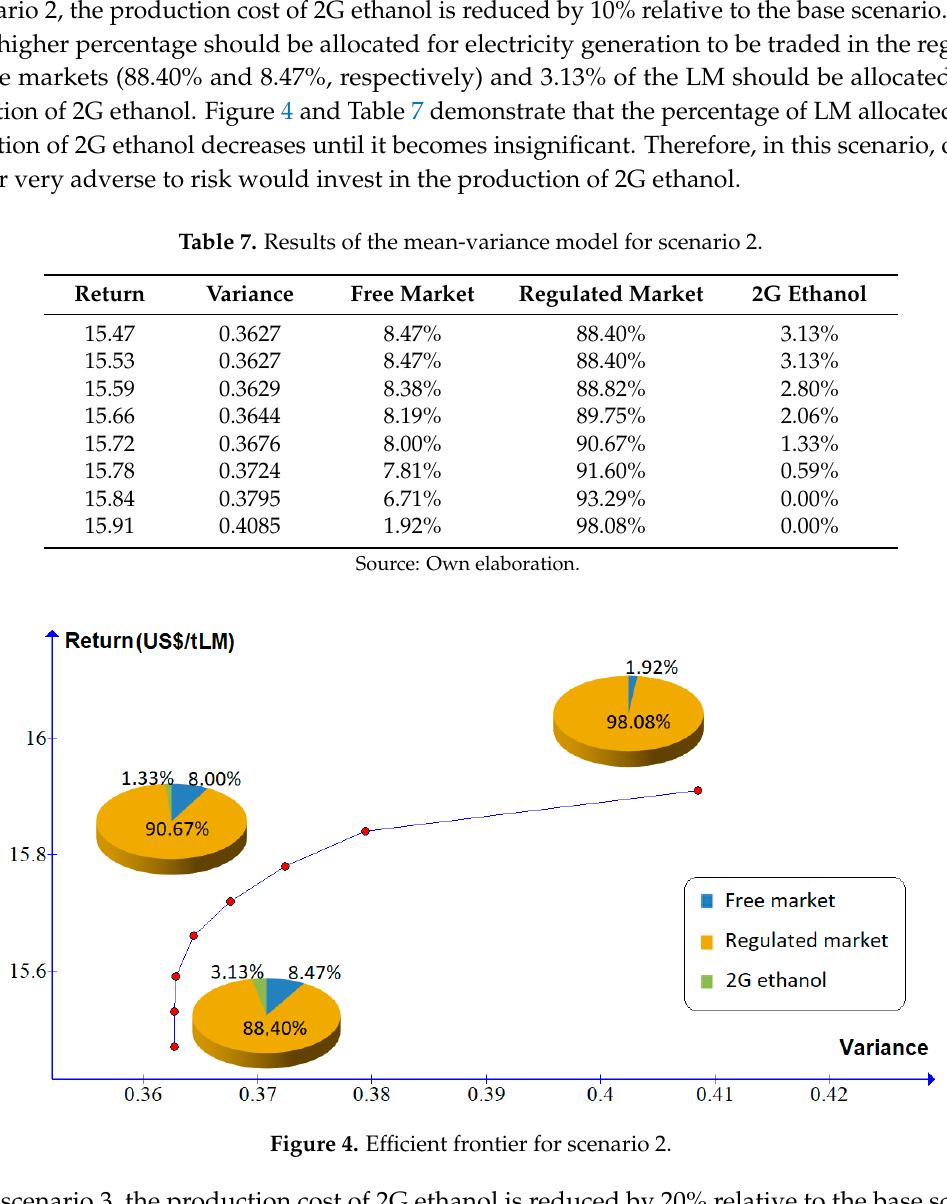
Figure 3. Efficient frontier for the base scenario.